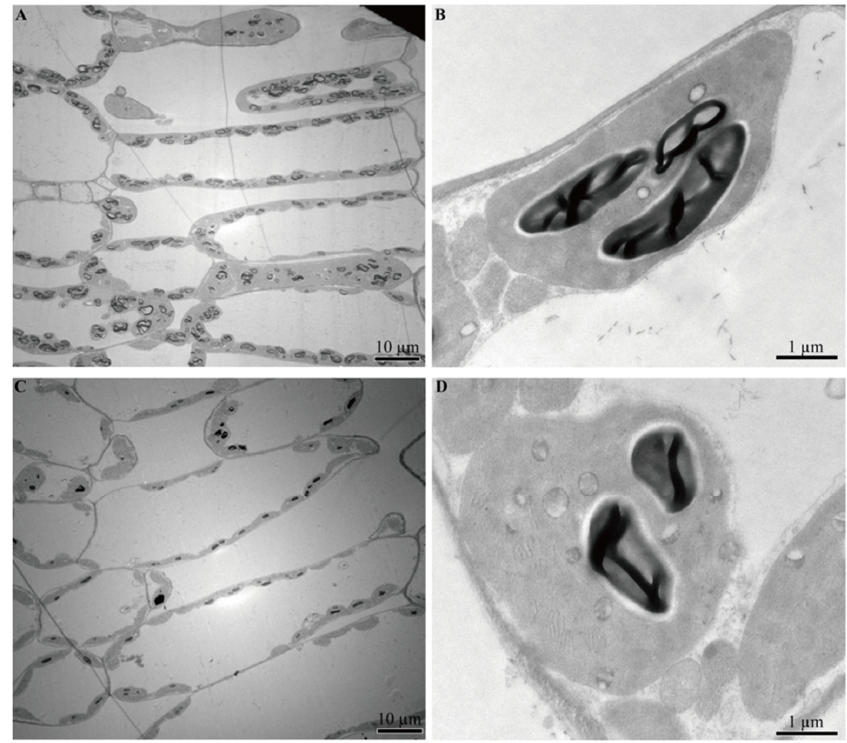
Figure 2. Transmission electron microscopy observation of ‘L45’ ( A , B ) and ‘L39’ ( C , D ) leaves under waterlogging stress for four days.